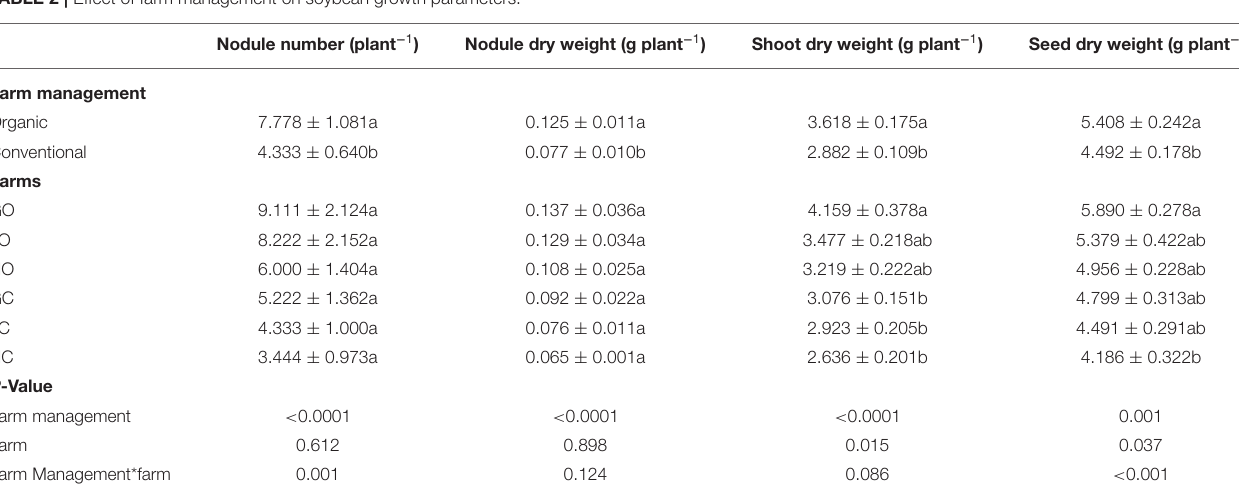
TABLE 2 | Effect of farm management on soybean growth